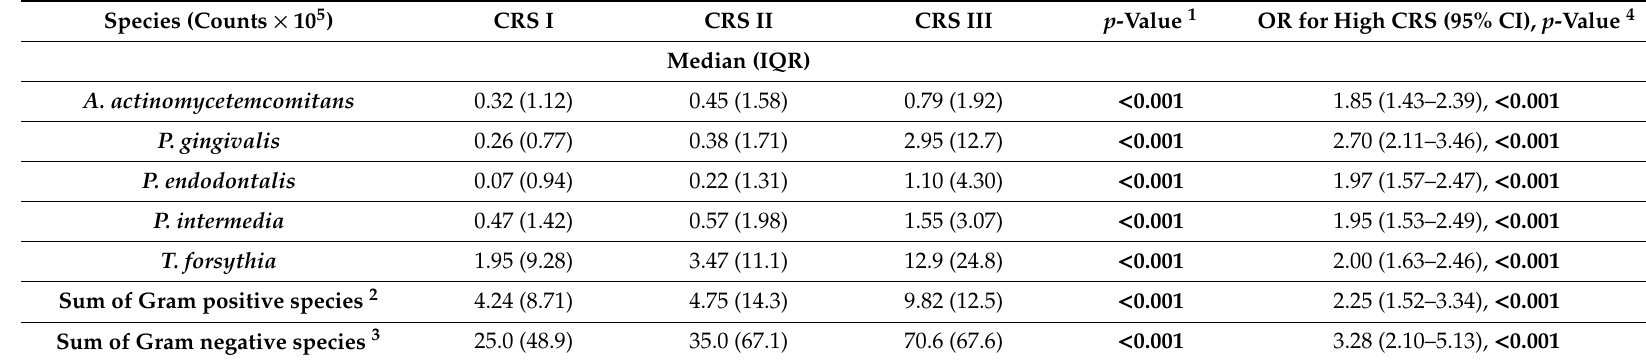
Table 4. Subgingival bacterial levels according to the CRS